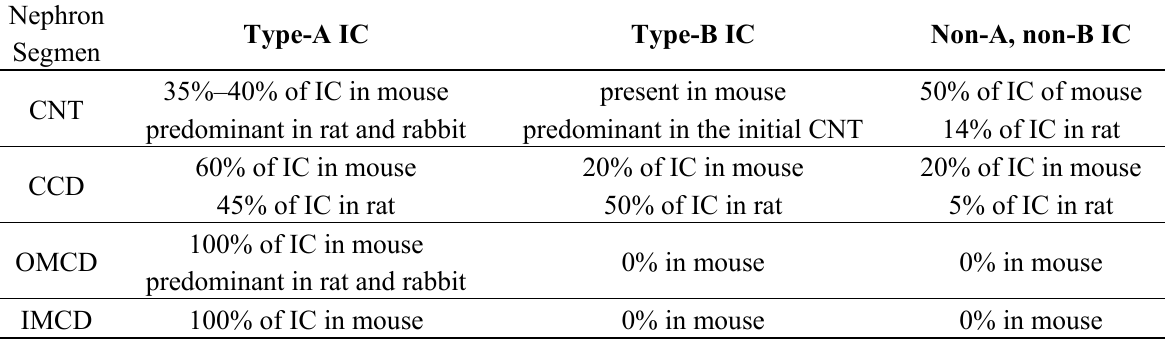
Table 1. Percentages of intercalated cells in various distal nephron segments in mouse, rat and rabbit. These rough percentages were assessed using electron microscopy and immunohistochemistry. The variations are likely due to diet differences and therefore may not reflect the situation in humans. CNT, connecting tubule, CCD, cortical collecting